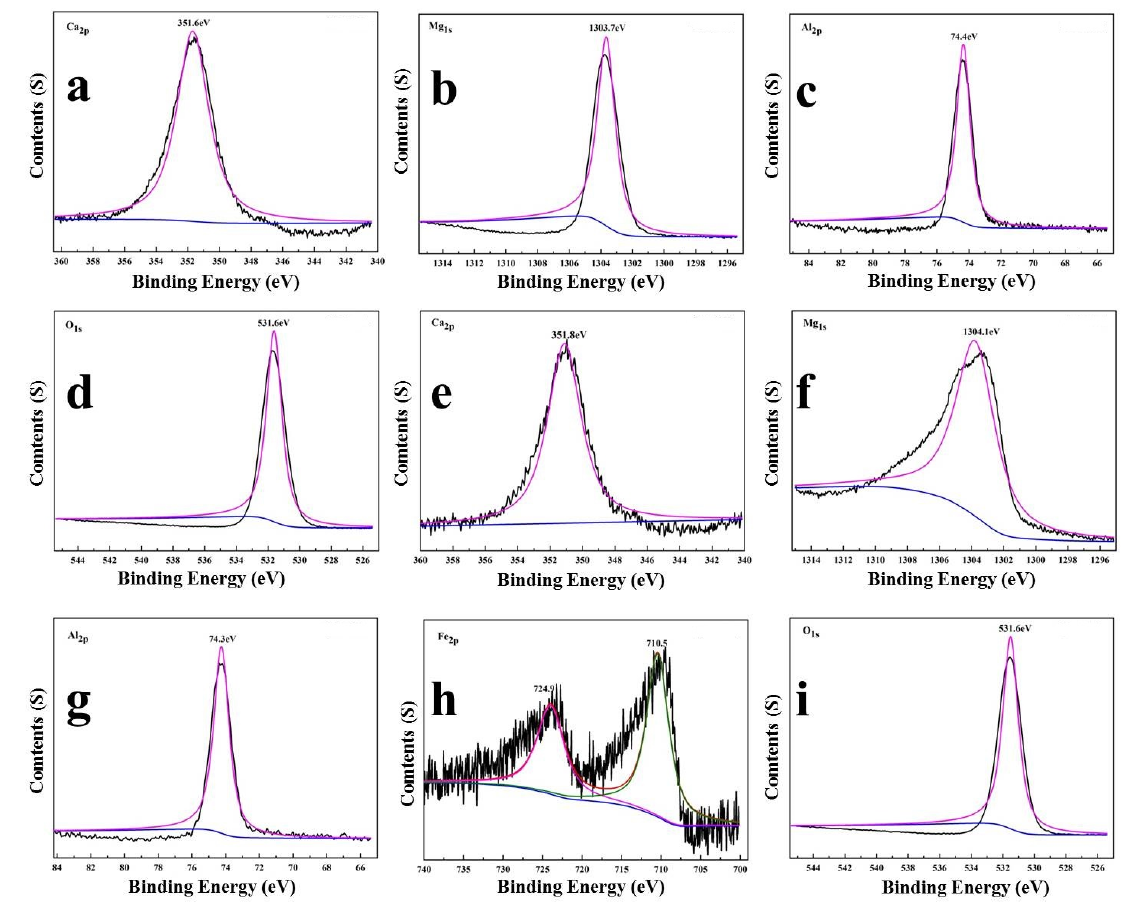
Figure 2. XPS survey ( a ) Ca 2p, ( b ) Mg 1s, ( c ) Al 2p, ( d ) O 1s for LDHs-1 and ( e ) Ca 2p, ( f ) Mg 1s, ( g ) Al 2p, ( h ) Fe 2p, ( i ) O 1s for LDHs-2.